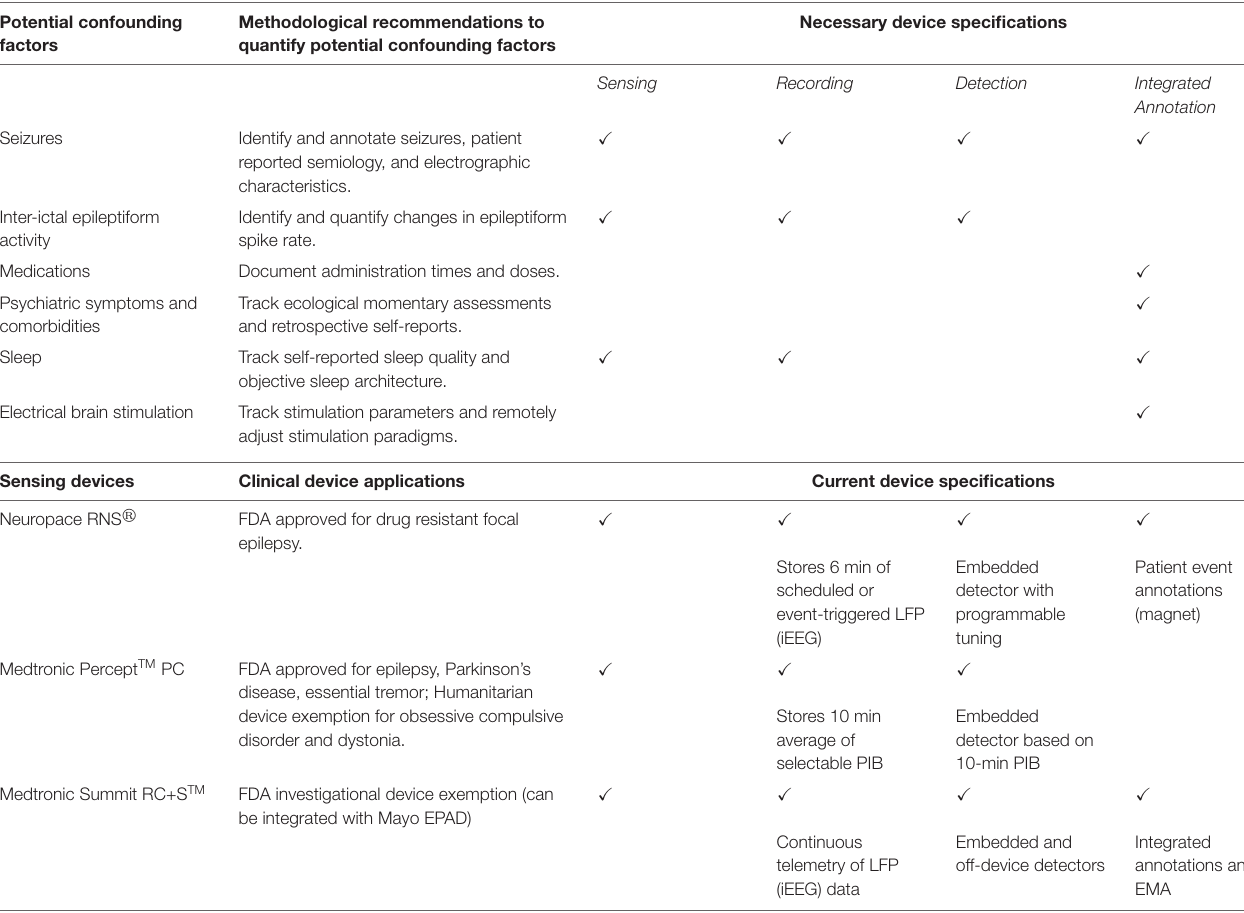
TABLE 1 | Quantifying factors that contribute to psychiatric symptoms in people with epilepsy: approaches and devices. Potential confounding